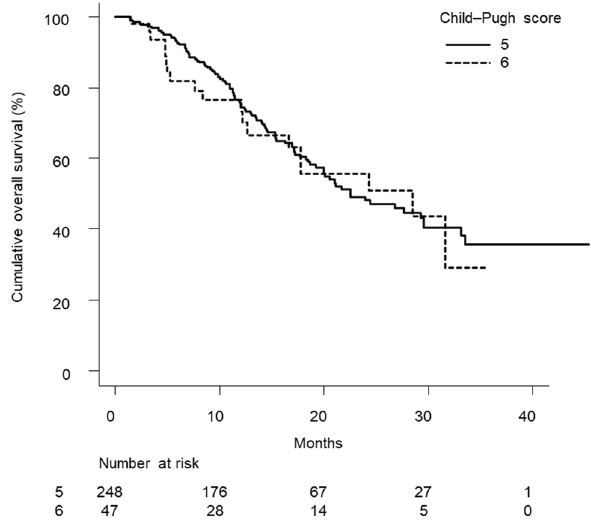
Figure 3. Cumulative survival curves in patients with mALBI grade 1/2a and Child–Pugh class A. There was no difference in cumulative overall survival between patients with mALBI grade 1/2a and Child–Pugh classes 5 and 6 ( p = 0.735). The median survival times in patients with mALBI grade 1/2a and Child–Pugh classes 5 and 6 were 22.5 (95%CI, 19.2–29.5) and 28.5 (95%CI, 12.7—not available) months, respectively. mALBI Modified albumin–bilirubin.